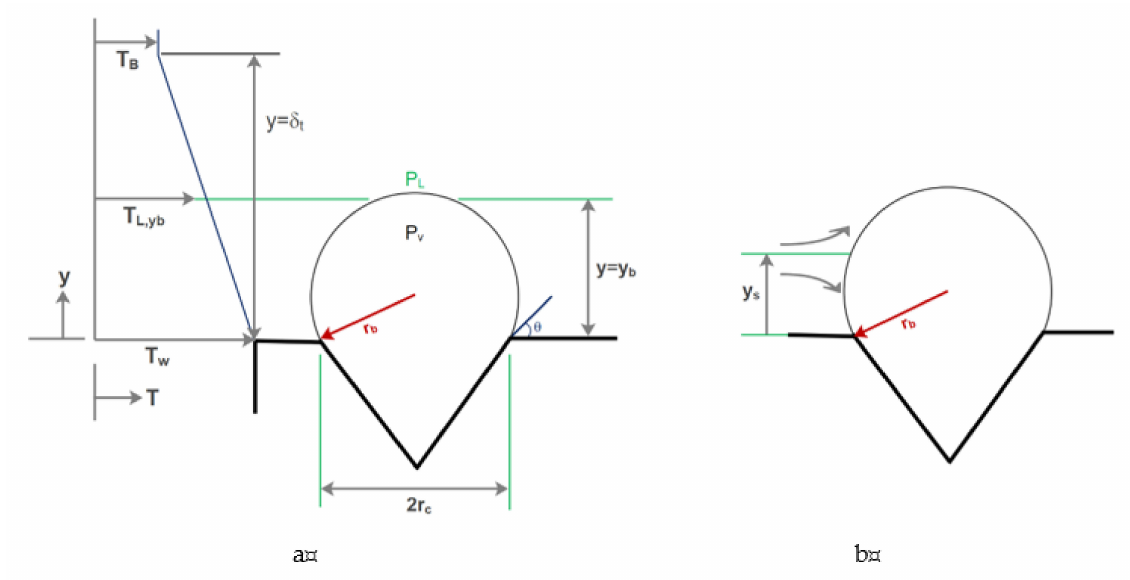
Figure 17. Temperature profile ( a ) and stagnation streamline ( b ) around a nucleating bubble